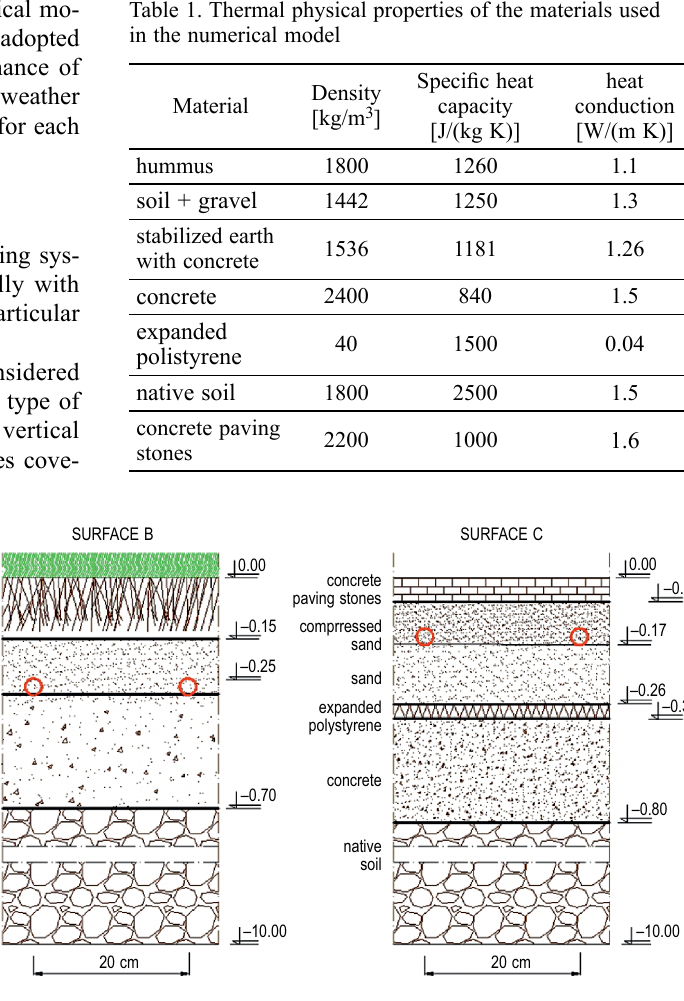
Fig. 1. Profile through the different heating surfaces